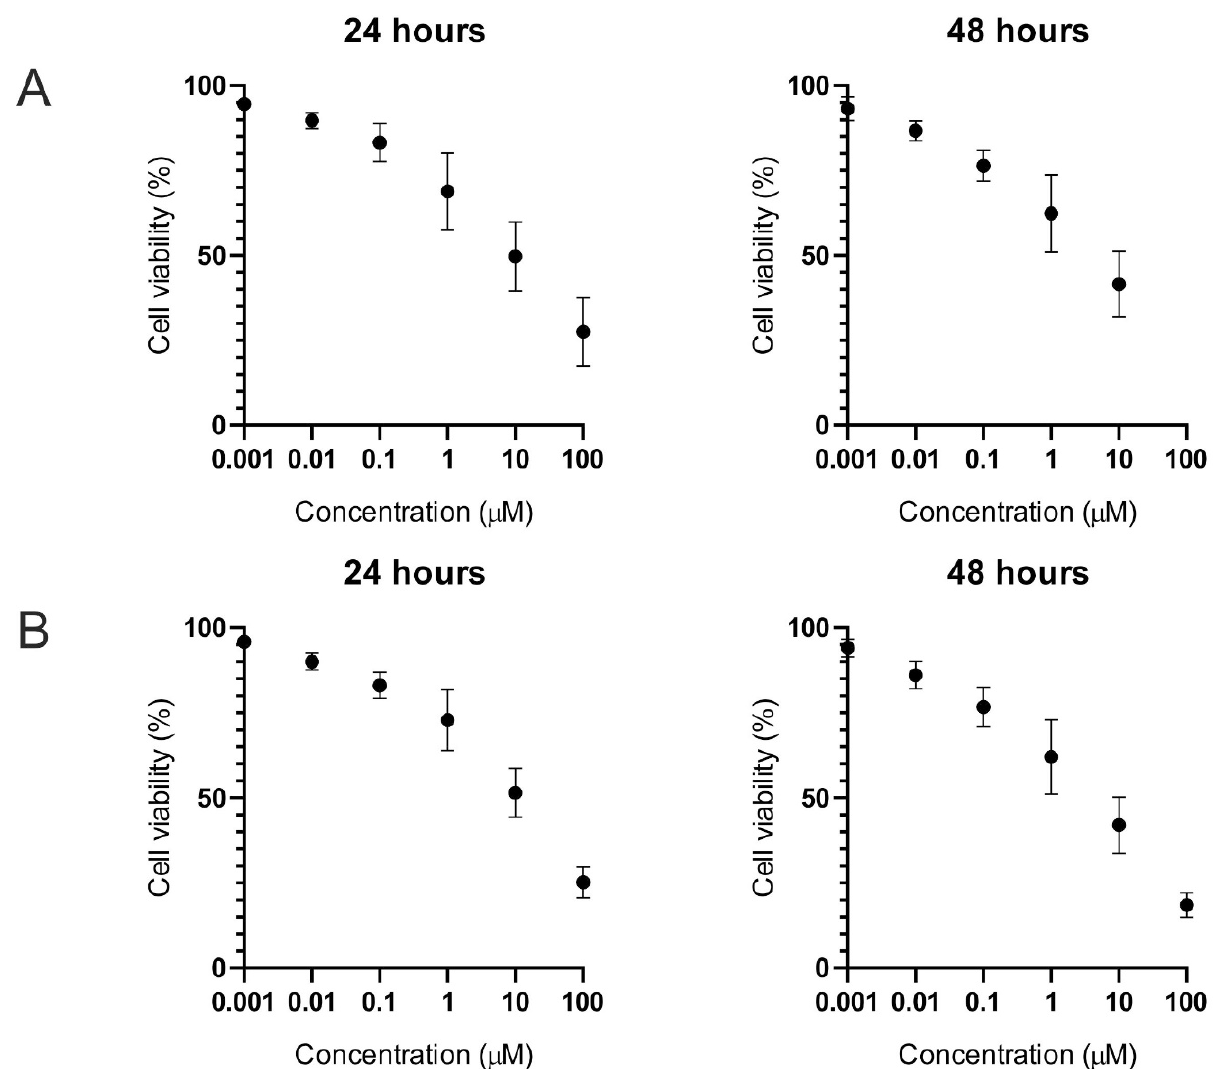
Figure 2. The T-2 toxin’s effect (in a concentration range from 0.001 to 100 µM) on Hs68 cell viability. Cell viability was estimated by using trypan blue ( A ) and MTT ( B ) methods. The data represent cell viability curves obtained from six independent measurements ( n = 6).